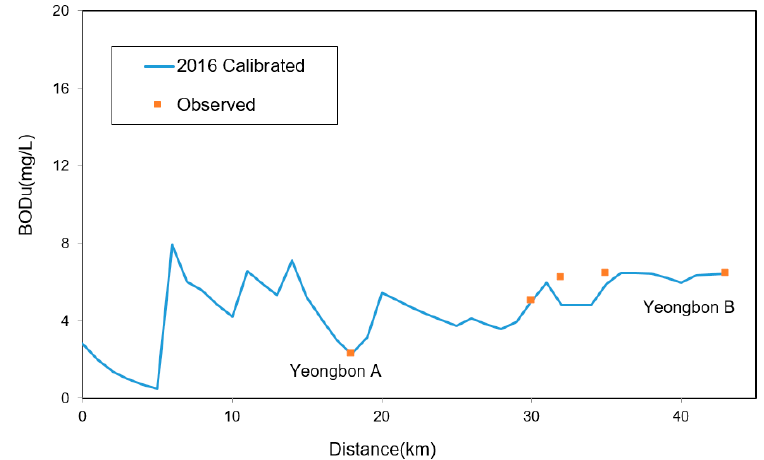
Figure 4. Calibration results for BOD in the main stem of the Yeongsan River: BODu is ultimate biochemical oxygen demand, and “observed” represents the water quality measurement results for the Yeongsan River in the low-flow season in 2016. “2016 Calibrated” represents calculated BODu after calibration in the low-flow season in 2016.